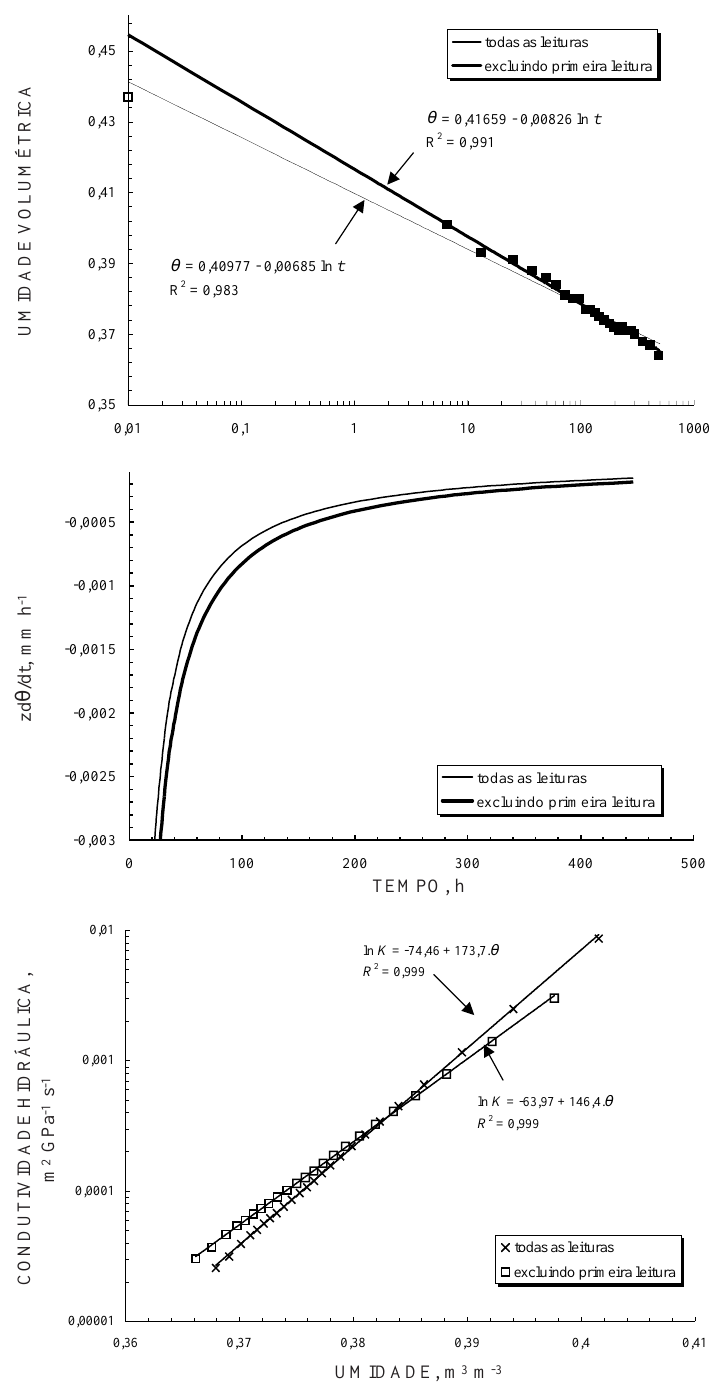
Figura 4. Seqüência exemplar mostrando como, no local A , a exclusão da primeira observação leva a (a) um ajuste diferente da relação entre a umidade e o tempo; (b) valores diferentes para z.d qqqqq /dt (variação da armazenagem) ao longo do tempo e (c) um resultado diferente para a relação K- qqqqq